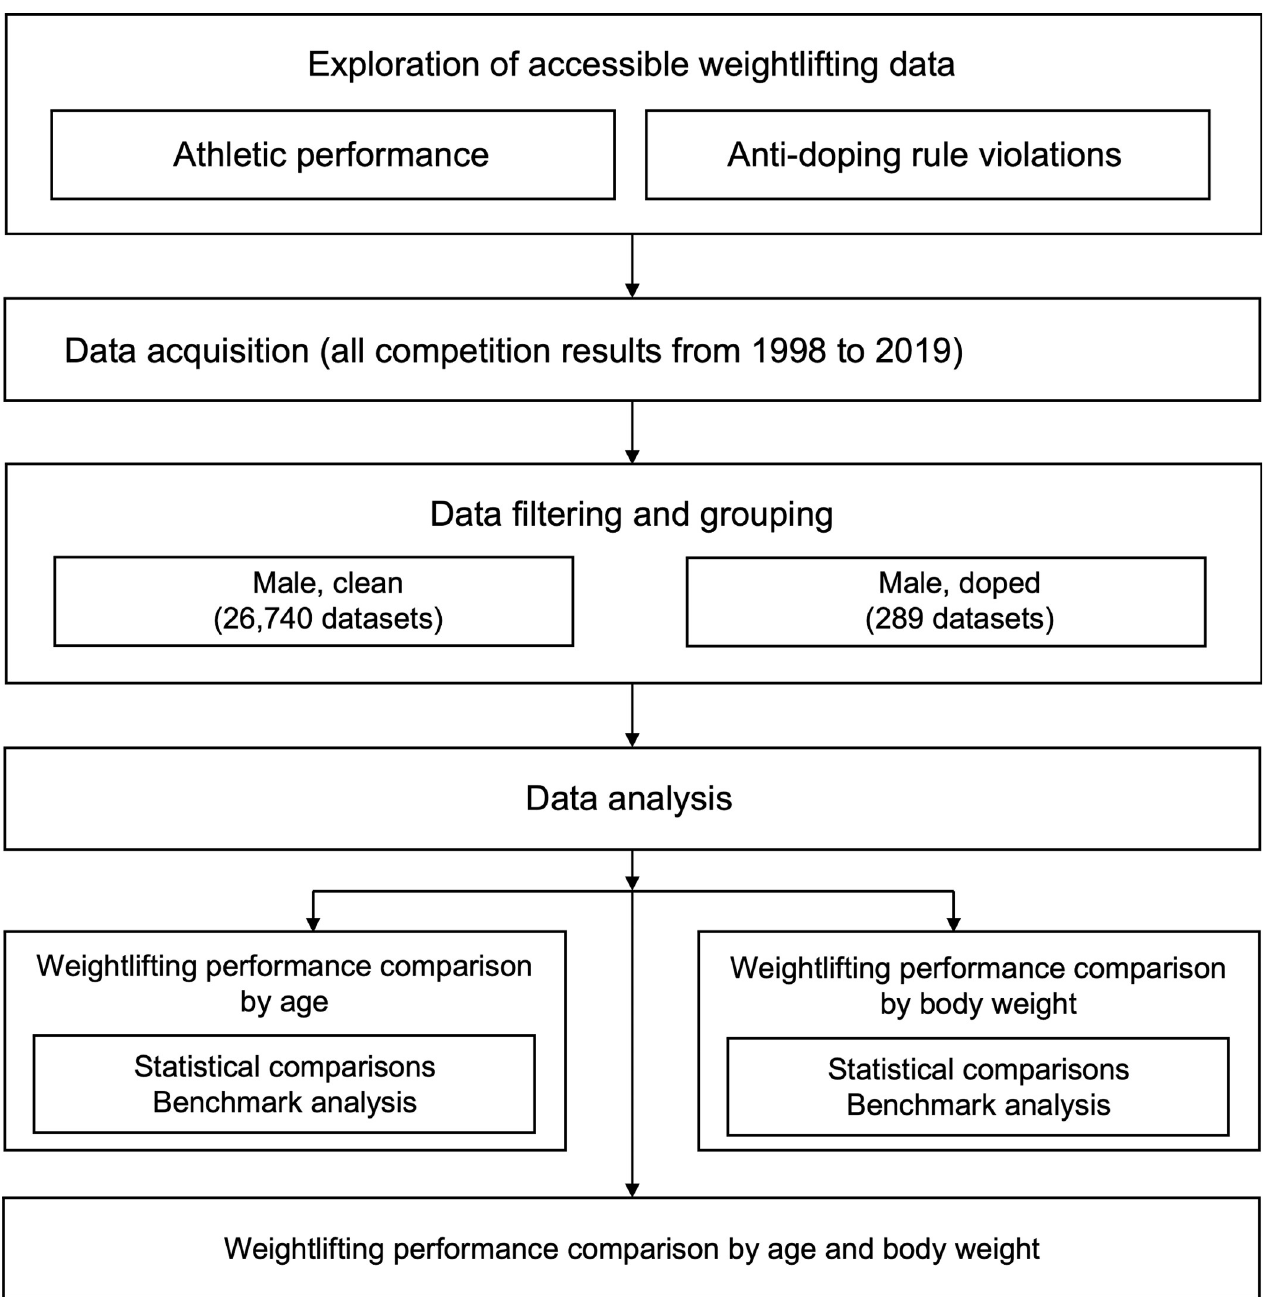
Fig 1. Experimental design of the